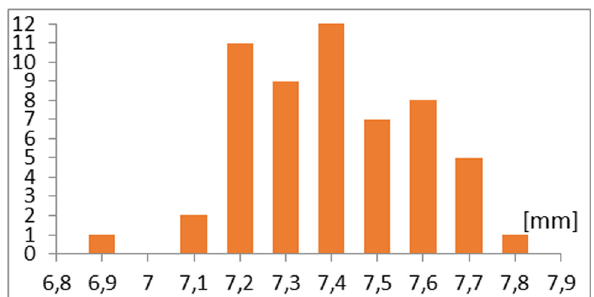
Figure 10: Histogram of random variation in thickness of corroded sheets obtained for the third coating sheet of the tank number 1. The measurements were taken in 2006. Mean value ( estimated from the sample ) 7.40 mm, standard deviation 0.19 mm, coe ffi cient of var - iation 0.026.